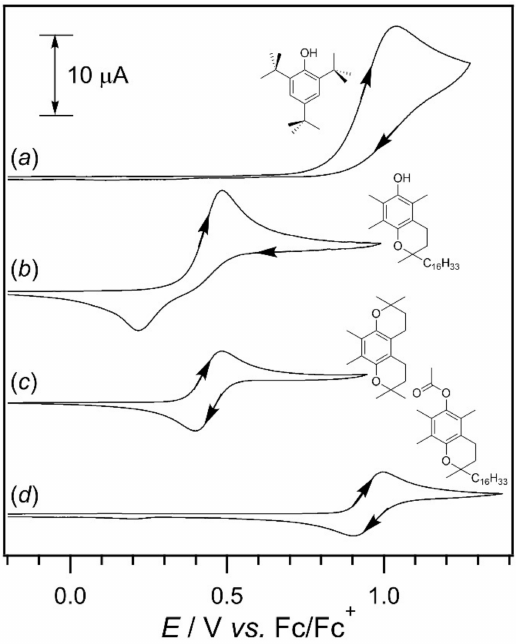
Figure 1. Cyclic voltammograms of ca. 2 mM substrates in CH 3 CN containing 0.25 M n –Bu 4 NPF 6 recorded at 0.1 V s − 1 scan rate at a 1 mm diameter planar circular Pt electrode at 22 ( ± 2) ◦ C. ( a ) 2,4,6– tri– tert –butylphenol [69]. ( b ) α –TOH [56]. ( c )